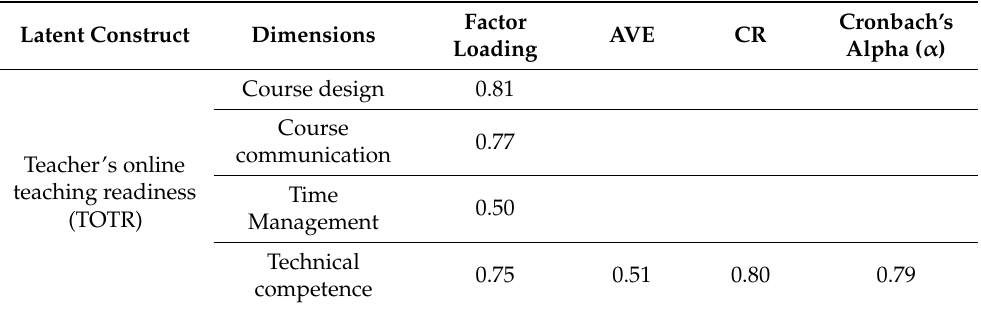
Table 3. Second-order measurement model results (Level-2).